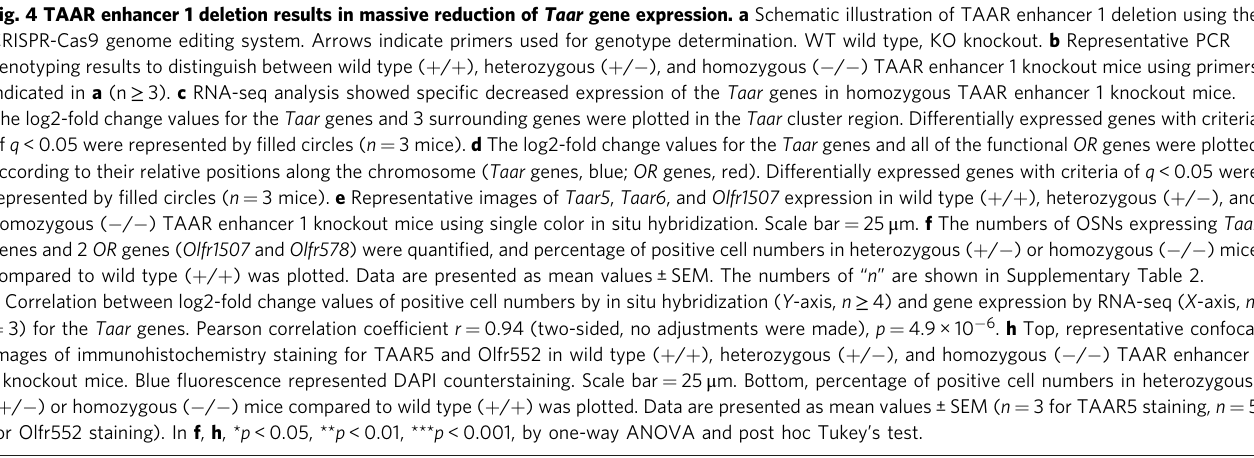
Fig. 4 TAAR enhancer 1 deletion results in massive reduction of Taar gene expression. a Schematic illustration of TAAR enhancer 1 deletion using the CRISPR-Cas9 genome editing system. Arrows indicate primers used for genotype determination. WT wild type, KO knockout. b Representative PCR genotyping results to distinguish between wild type ( + / + ), heterozygous ( + / − ), and homozygous ( − / − ) TAAR enhancer 1 knockout mice using primers indicated in a (n ≥ 3). c RNA-seq analysis showed speci fi c decreased expression of the Taar genes in homozygous TAAR enhancer 1 knockout mice. The log2-fold change values for the Taar genes and 3 surrounding genes were plotted in the Taar cluster region. Differentially expressed genes with criteria of q < 0.05 were represented by fi lled circles ( n = 3 mice). d The log2-fold change values for the Taar genes and all of the functional OR genes were plotted according to their relative positions along the chromosome ( Taar genes, blue; OR genes, red). Differentially expressed genes with criteria of q < 0.05 were represented by fi lled circles ( n = 3 mice). e Representative images of Taar5 , Taar6 , and Olfr1507 expression in wild type ( + / + ), heterozygous ( + / − ), and homozygous ( − / − ) TAAR enhancer 1 knockout mice using single color in situ hybridization. Scale bar = 25 μ m. f The numbers of OSNs expressing Taar genes and 2 OR genes ( Olfr1507 and Olfr578 ) were quanti fi ed, and percentage of positive cell numbers in heterozygous ( + / − ) or homozygous ( − / − ) mice compared to wild type ( + / + ) was plotted. Data are presented as mean values ± SEM. The numbers of “ n ” are shown in Supplementary Table 2. g Correlation between log2-fold change values of positive cell numbers by in situ hybridization ( Y -axis, n ≥ 4) and gene expression by RNA-seq ( X -axis, n = 3) for the Taar genes. Pearson correlation coef fi cient r = 0.94 (two-sided, no adjustments were made), p = 4.9 × 10 − 6 . h Top, representative confocal images of immunohistochemistry staining for TAAR5 and Olfr552 in wild type ( + / + ), heterozygous ( + / − ), and homozygous ( − / − ) TAAR enhancer 1 knockout mice. Blue fl uorescence represented DAPI counterstaining. Scale bar = 25 μ m. Bottom, percentage of positive cell numbers in heterozygous ( + / − ) or homozygous ( − / − ) mice compared to wild type ( + / + ) was plotted. Data are presented as mean values ± SEM ( n = 3 for TAAR5 staining, n = 5 for Olfr552 staining). In f , h , * p < 0.05, ** p < 0.01, *** p < 0.001, by one-way ANOVA and post hoc Tukey ’